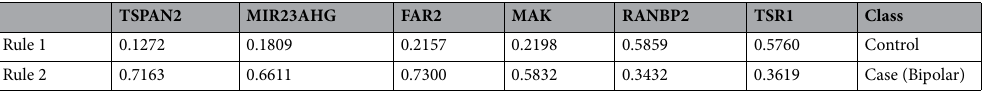
Table 3. Example rules from the BP dataset. Personalised classification rules from a randomly selected sample in the BP